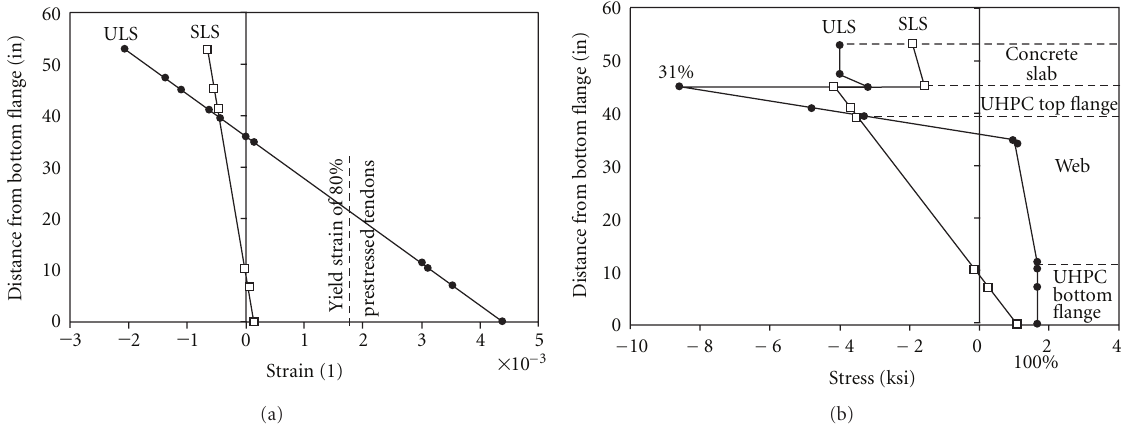
Figure 7: Strain (a) and stress (b) profiles in the beam section at SLS and